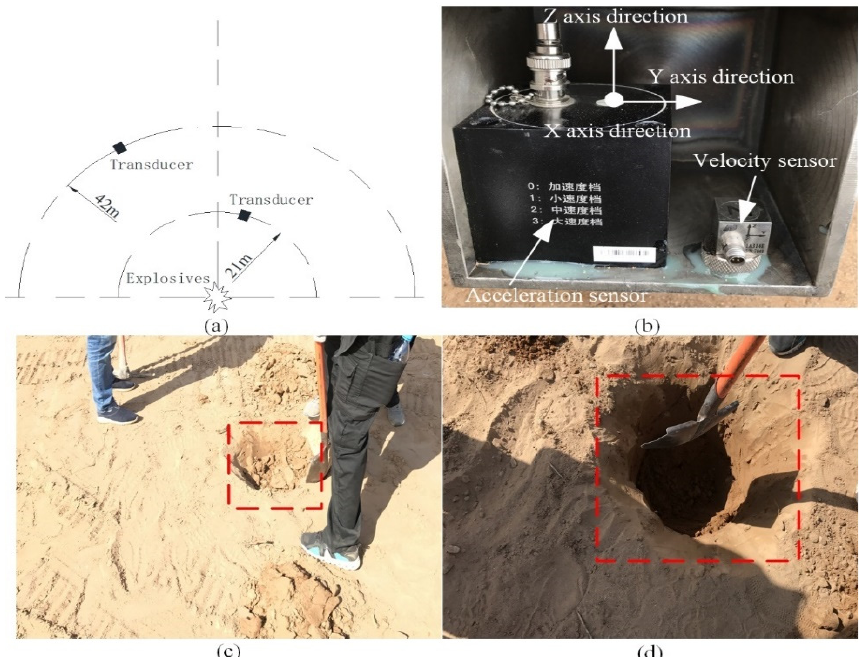
Figure 3. Sensor layout and photographs of the sensors, ( a ) layout of the sensors, ( b ) photograph of the sensors, ( c , d ) the